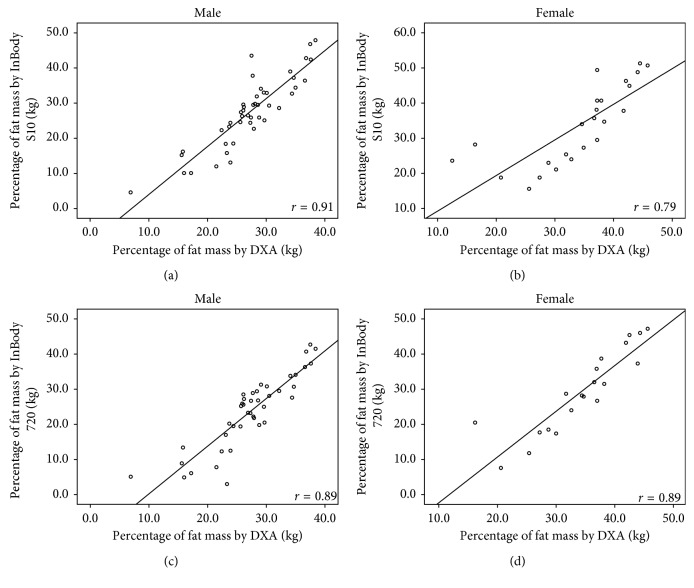
Correlation between percentages of fat mass in hemodialysis patients: (a) measured by DXA and BIA S10 in male, (b) measured by DXA and BIA S10 in female, (c) measured by DXA and BIA 720 in male, and (d) measured by DXA and BIA 720 in female.